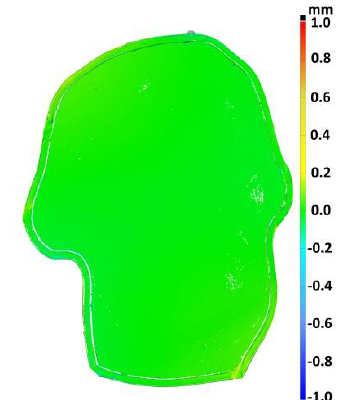
Figure 9. 3D inspection of a glass pane of nXI3b from Legnica.